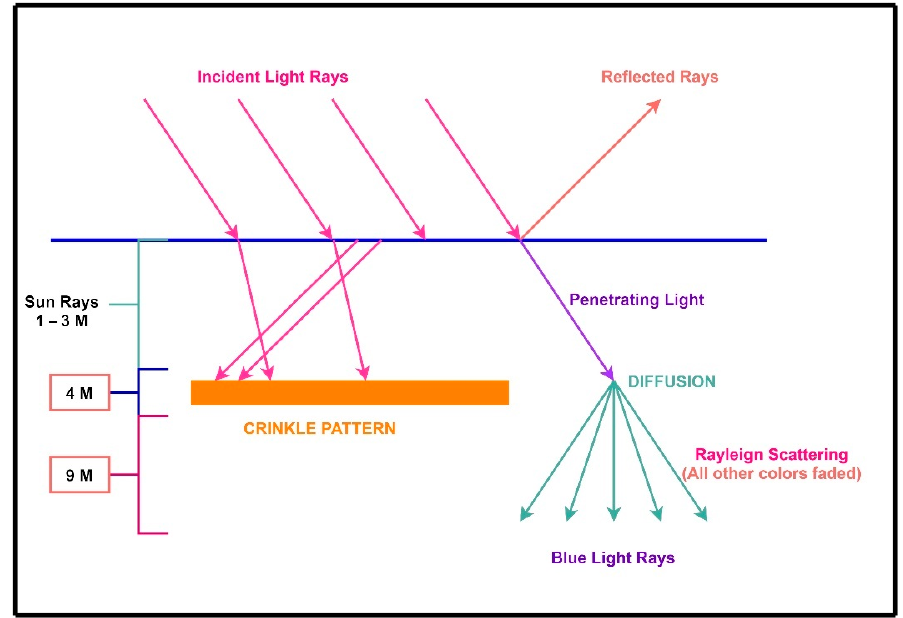
Figure 2. Reflection of light in water .